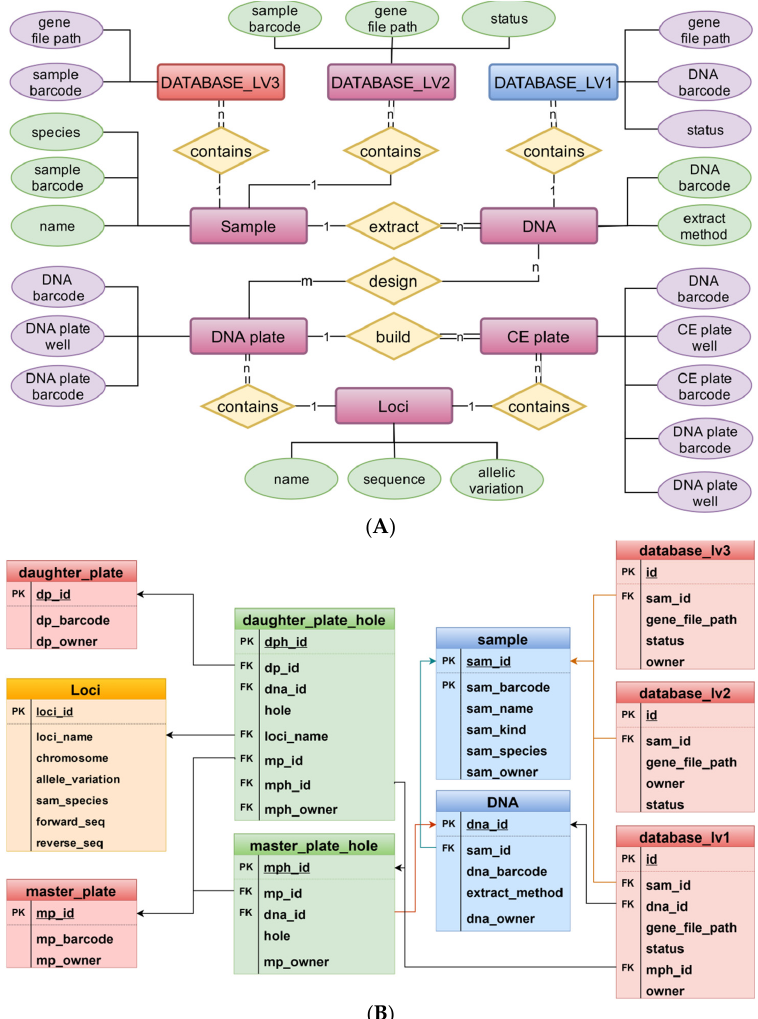
Figure 4. PSNPdms entity-relationship and class-table model. ( A ) The “Chen ERD” representation of the entity-relationship model diagram (ERD). Rectangles represent the key entity objects, a single line, double line, and rhombus represent the association between the entity objects, and an ellipse represents the important information contained in each entity content. ( B ) The class-table model relationship diagram constructed based on the ERD diagram. PK indicates that the field is a primary key and is unique in the table; FK indicates that the field is a foreign key, and an arrow indicates that the field is associated with other tables, describing the association between various key data tables.